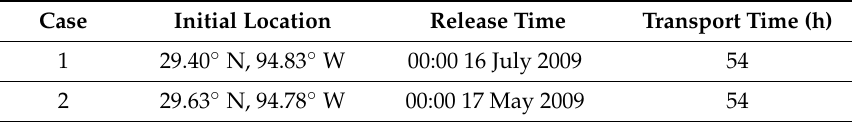
Table 1. The hypothetical spill information for the two